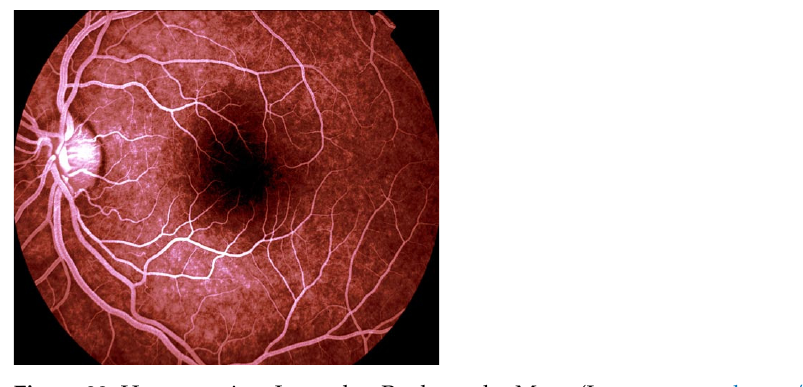
Figure 38. Human retina. Image by: Paul van der Meer. (Image source: https://fractalfoundation. org/OFC/OFC-1-3.html, accessed on 22 June